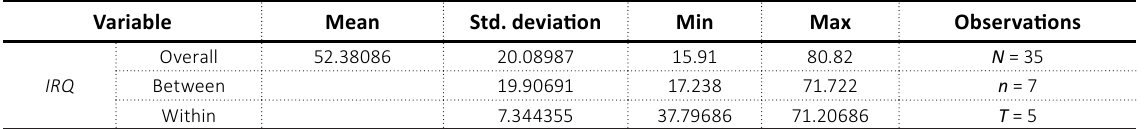
Table 2. Descriptive statistics of the integrated reporting quality of the banks